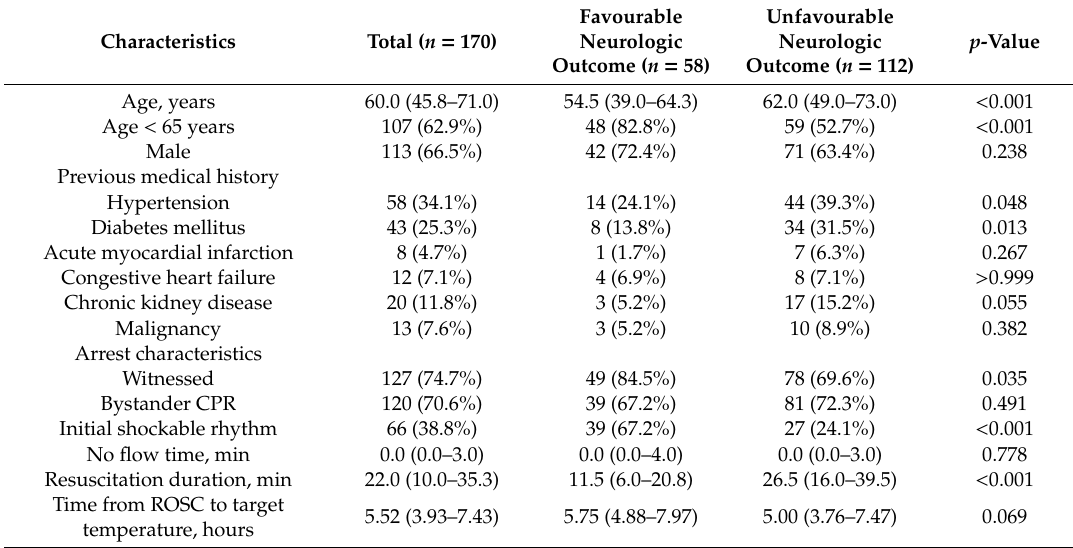
Table 1. Demographic and clinical characteristics of patients with out-of-hospital cardiac arrest treated with targeted temperature management according to neurologic outcome at 6